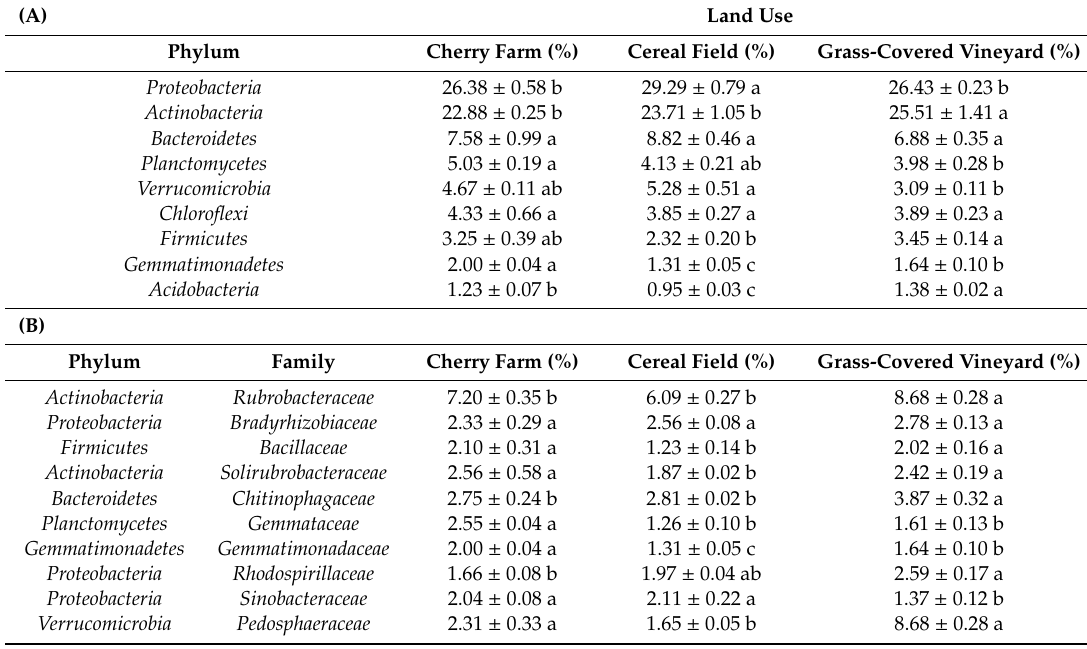
Table 9. Relative abundance of ( A ) bacterial phyla (relative abundance > 1%) and ( B ) families (relative abundance > 2%) under di ff erent land